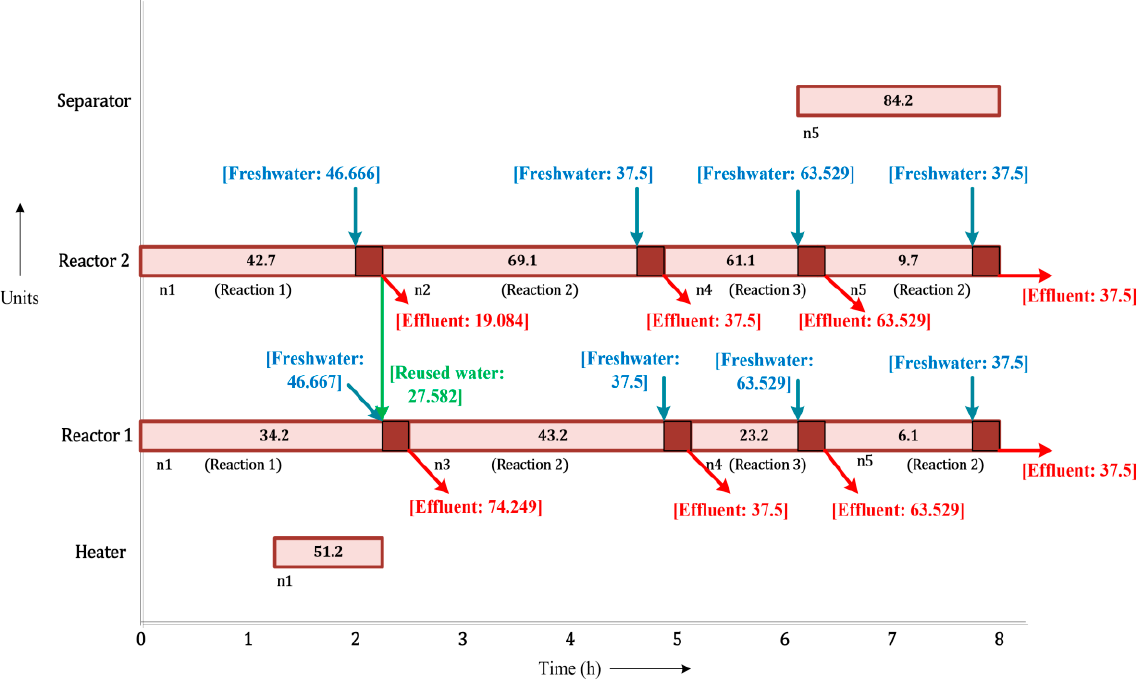
Figure 5. Production schedule obtained for the sequential approach.